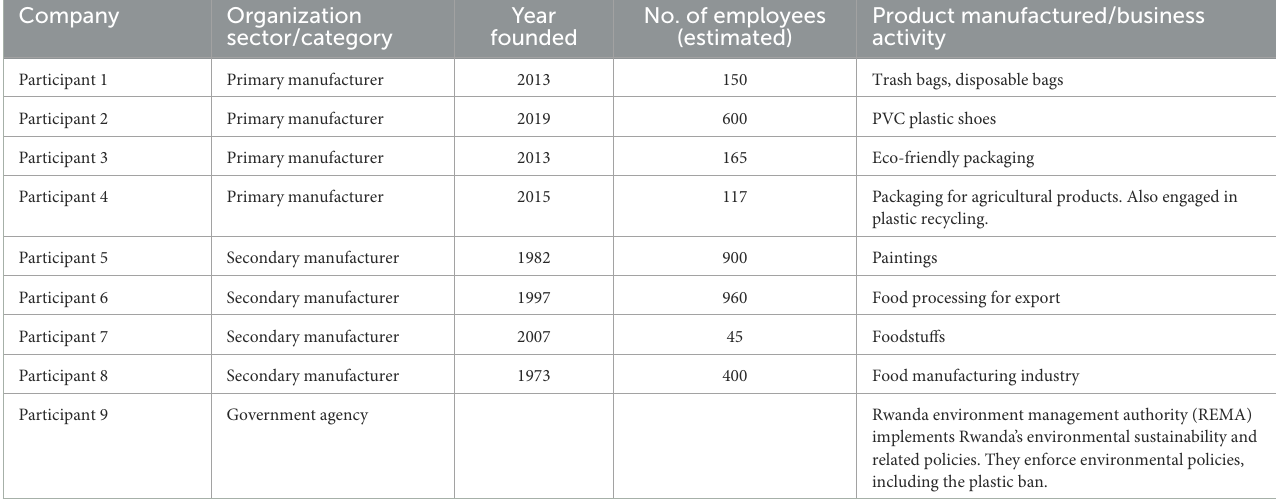
TABLE 3 Demographic data of the firms